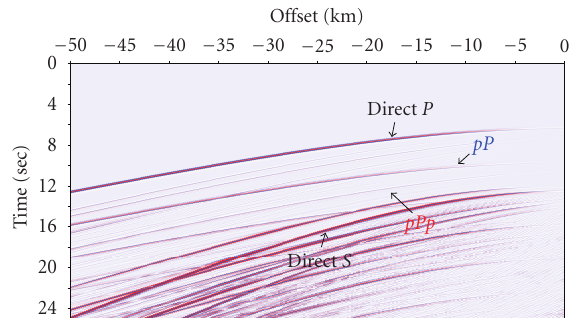
Figure 5: Vertical component of the modeled seismic wavefields. Arrows indicate the dominated events.